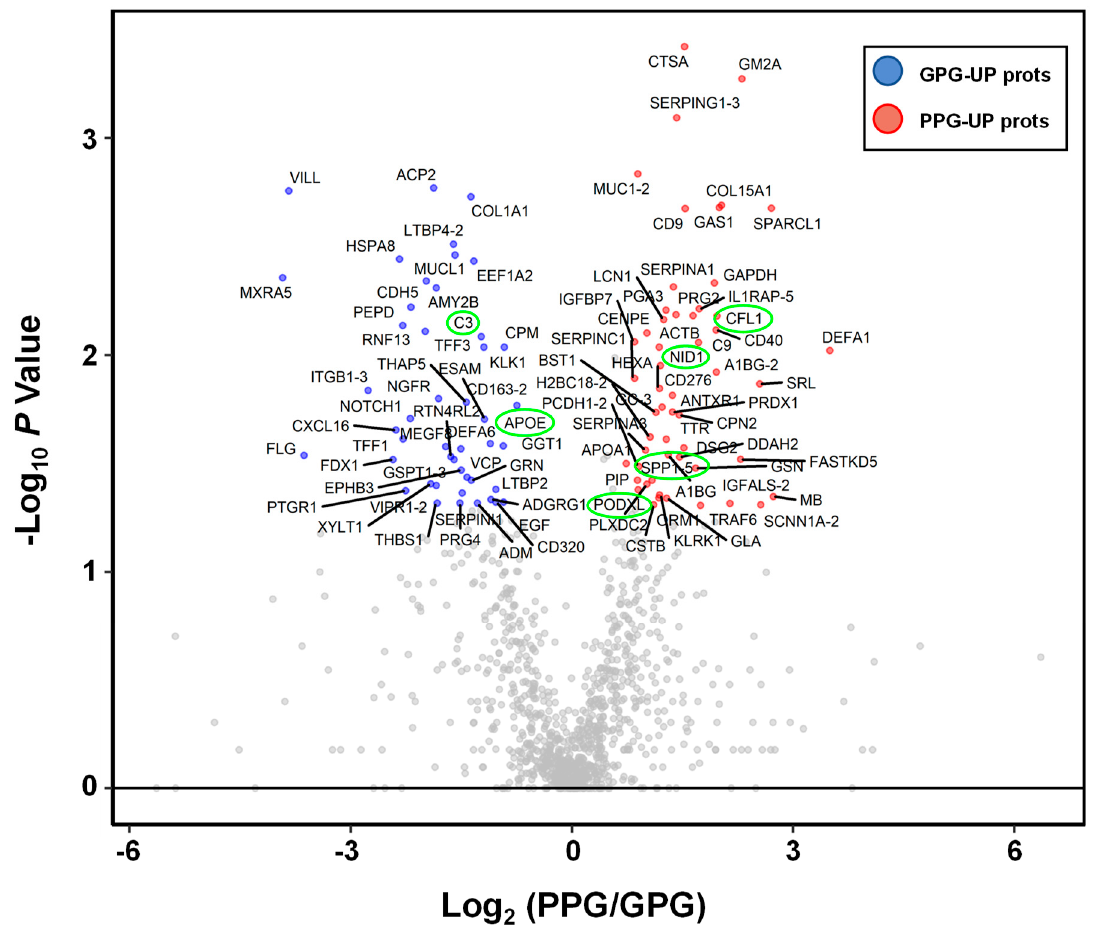
Figure 2. Volcano plot of urinary proteomic data. Volcano plots are depicted with the fold change of each protein abundance and the p value was calculated by performing a Mann–Whitney U-test. The averages of the urinary proteomic abundance data of good prognostic group ( N = 35) were compared with the averages of the data for poor prognostic group ( N = 19). Red circles show 54 urinary proteins that have significant increases in PPG. Blue circles show 46 urinary proteins which have significant decreases in PPG. Gray circles are urinary proteins without statistical meaning. Green circles are previously released as urinary protein markers for glomerular injury or tubular injury.